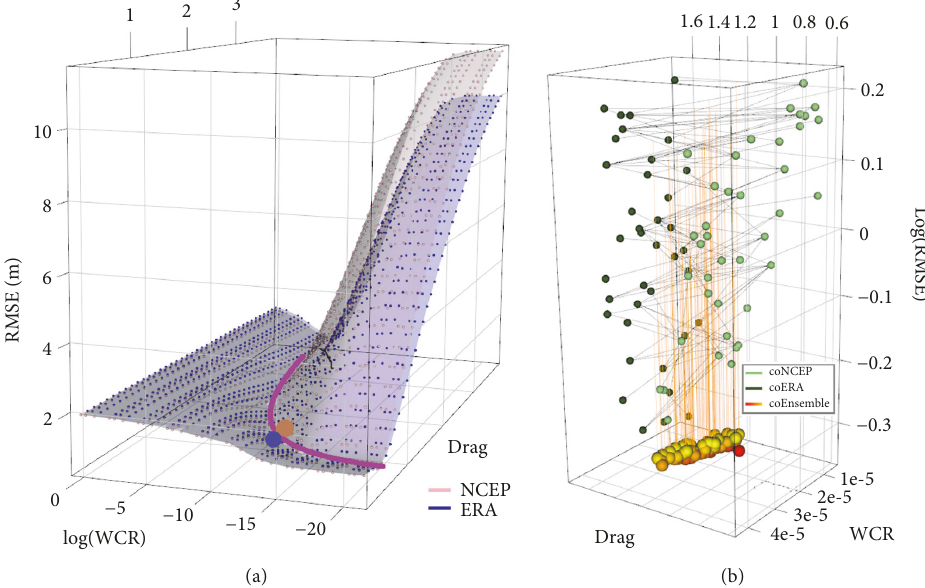
Figure 4: Metocean simulation: (a) error landscape for wave height simulation results using ERA and NCEP reanalysis as input data and (b) Pareto frontier of coevolution results for all generations.